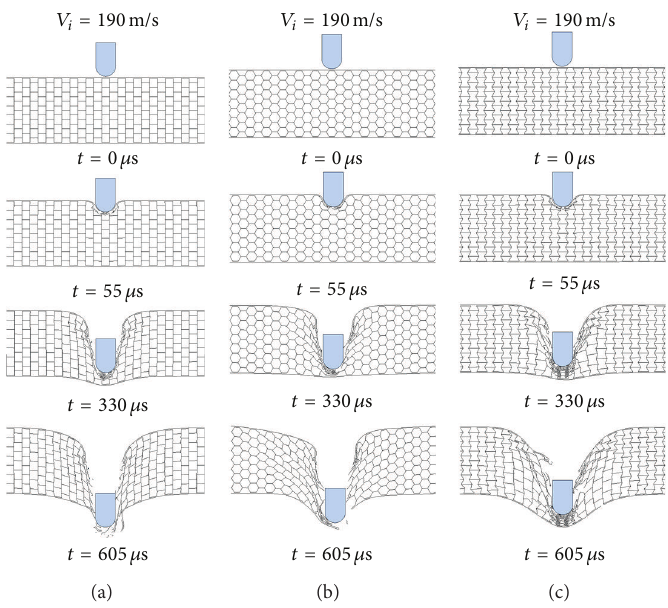
Figure 10: Impact processes of (a) R-type, (b) H-type, and (c) A-type HSPs by the projectile at 𝑉 𝑖 = 190 m/s.